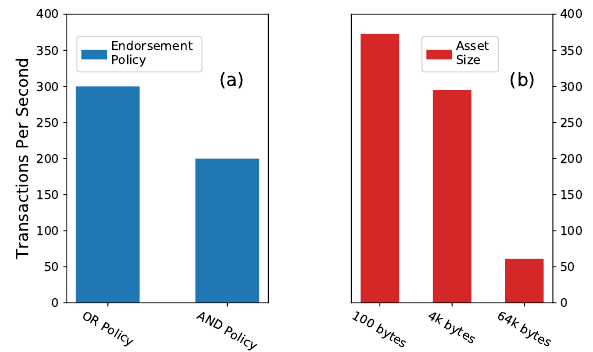
Figure 7. Performance references for hyperledger fabric. ( a ) The transactions per second based on an endorsement policy requiring either of the two organizations to approve transactions (OR Policy) and bath of the organizations to approve the transactions (AND Policy) [38]. ( b ) The variation in performance based on the size of the asset created in the transaction